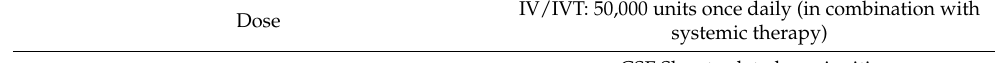
IV/IVT: 50,000 units once daily (in combination with systemic therapy)